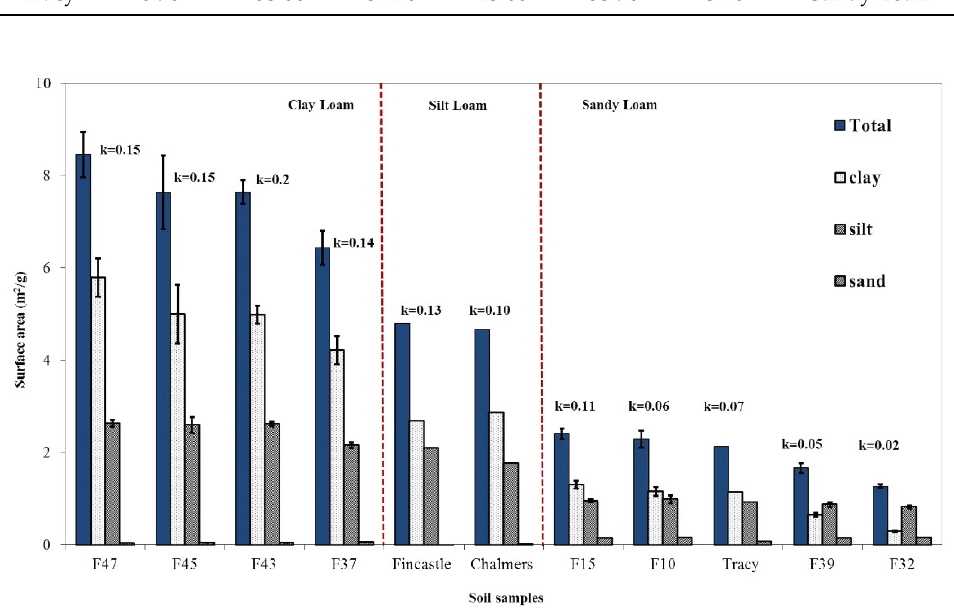
Figure 5. Overall total surface area and surface area for clay, silt, and sand components for soils [8]. The average and deviation of mineral soil surface area are shown.